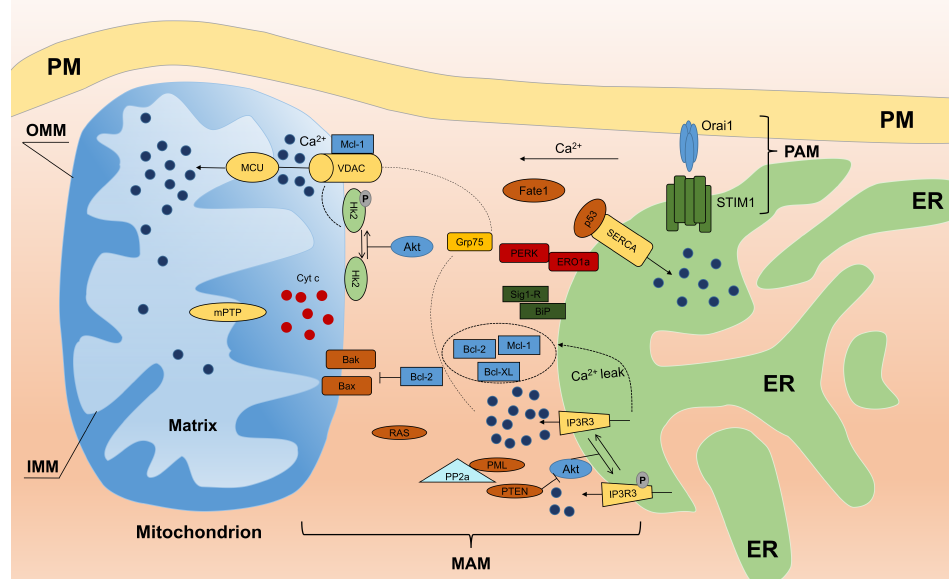
Figure 2. Proteins involved in Ca 2 + homeostasis at MAM and PAM fractions. Bak, Bcl-2 antagonist/killer; Bax, Bcl-2 associated X protein; Bcl-2, B-cell CLL/lymphoma 2; BIP1, or GRP78, glucose regulated protein 78; cyt. c, cytochrome c; ER, endoplasmic reticulum; GRP75, glucose regulated protein 75; HK2, hexokinase 2; IP3R, inositol 1,4,5 trisphosphate receptor; MAM, mitochondria associated membranes; Mcl-1, myeloid cell leukemia sequence 1; MCU, mitochondrial calcium uniporter; mPTP, mitochondrial permeability transition pore; Orai1, ORAI Calcium Release-Activated Calcium Modulator 1; PAM, plasma membrane associated membranes; PM, plasma membrane; PML, promyelocytic leukemia protein; PTEN, phosphatase and tensin homolog deleted on chromosome 10; SERCA, sarco/endoplasmatic reticulum Ca 2 + ATPase; Sig1R, Sigma 1 receptor; STIM1, Stromal interaction molecule 1; VDAC, voltage-dependent anion